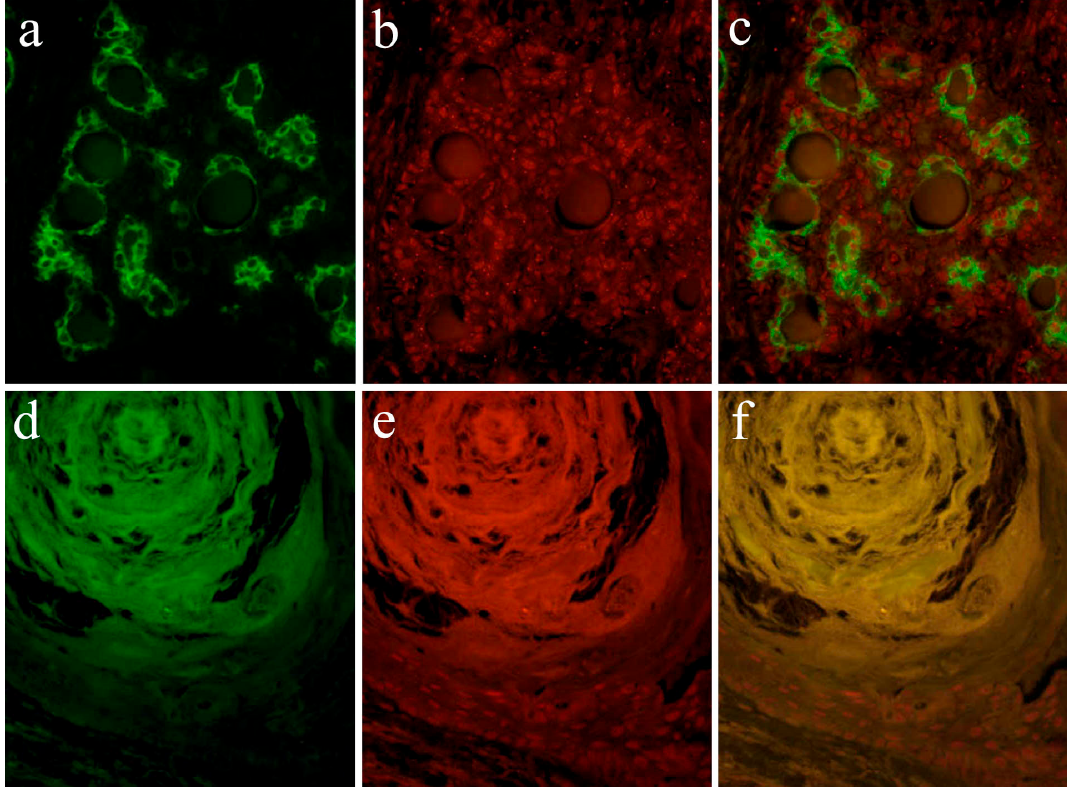
Figure 9. Immunofluorescent staining images of the formation of the ductal structure. ( a ) Green color indicates the localization of CK7, and is found in ductal cells. ( b ) Red color indicates the Notch1 localization, and ( c ) merged image of CK7 and Notch1.; Immunofluorescent staining images of squamous metaplasia. ( d ) Green color indicates the CK13 localization, and is found in squamous epithelial cells. ( e ) The nuclear localization of Notch1 is shown in red color in basal cells, and ( f ) merged image of CK13 and Notch1. Magnification × 100. Anti-Cytokeratin 7 antibody, abcam, [RCK105], ab9021, 1:100; anti-Cytokeratin 13 antibody, abcam, [AE8], ab16112, 1:100; anti-Notch-1 intracellular domain antibody, Abcam, ab83232, 1:100.